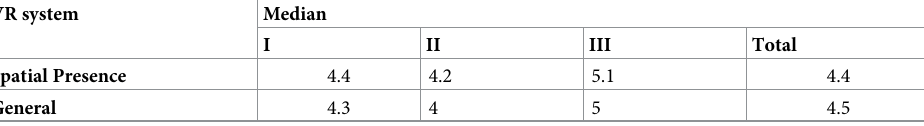
Table 9. Median of general and spatial presence (Scores are out of 6).